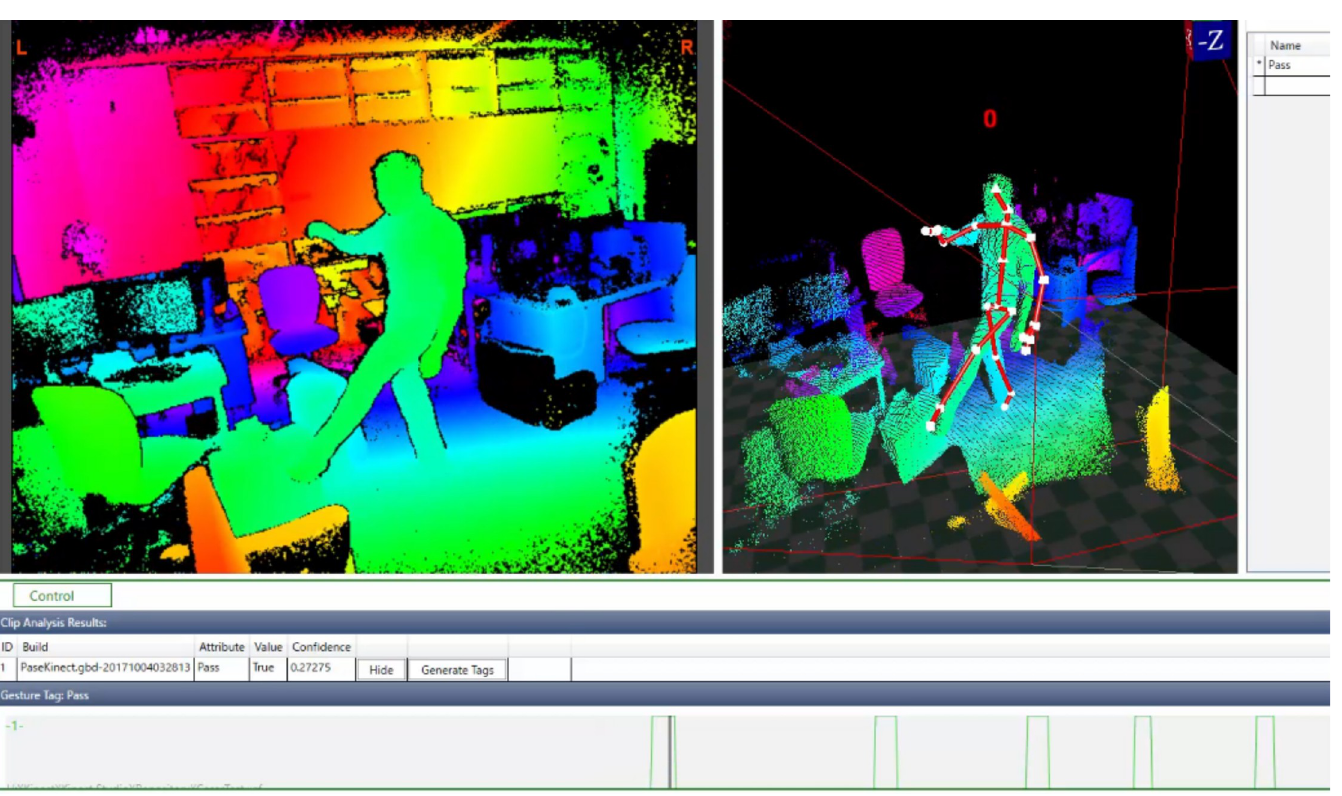
Fig 3. One of the eight video clips used to train the gesture recognition algorithm. The small blue lines in the timeline at the bottom of the image denote the manually tagged passing actions.